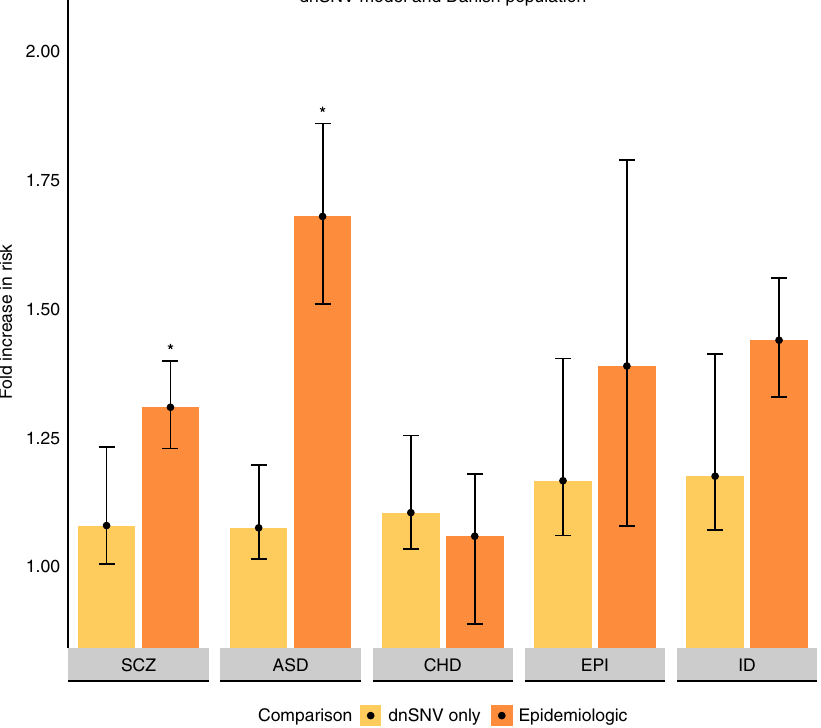
Fig. 2 Disease risk in offspring of older fathers vs. offspring of younger fathers in dnSNV model and Danish population. SCZ schizophrenia, ASD autism spectrum disorder, CHD congenital heart disease, EPI neurodevelopmental disorders with epilepsy, ID intellectual disability. Error bars re fl ect 95% con fi dence intervals. * p < 2 × 10 − 4 against null hypothesis that epidemiologic association between advanced paternal age and disease risk is equivalent